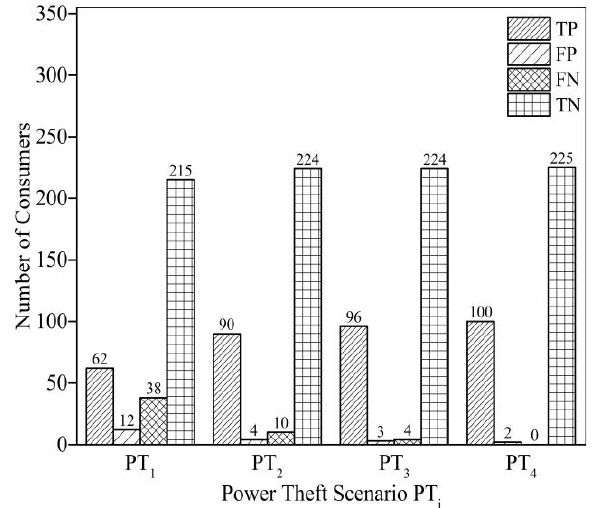
Energies 2020 , 13 , x FOR PEER REVIEW Figure 5. Confusion matrix for partial power theft scenarios (PT i ). Figure 5. Confusion matrix for partial power theft scenarios (PT i ).